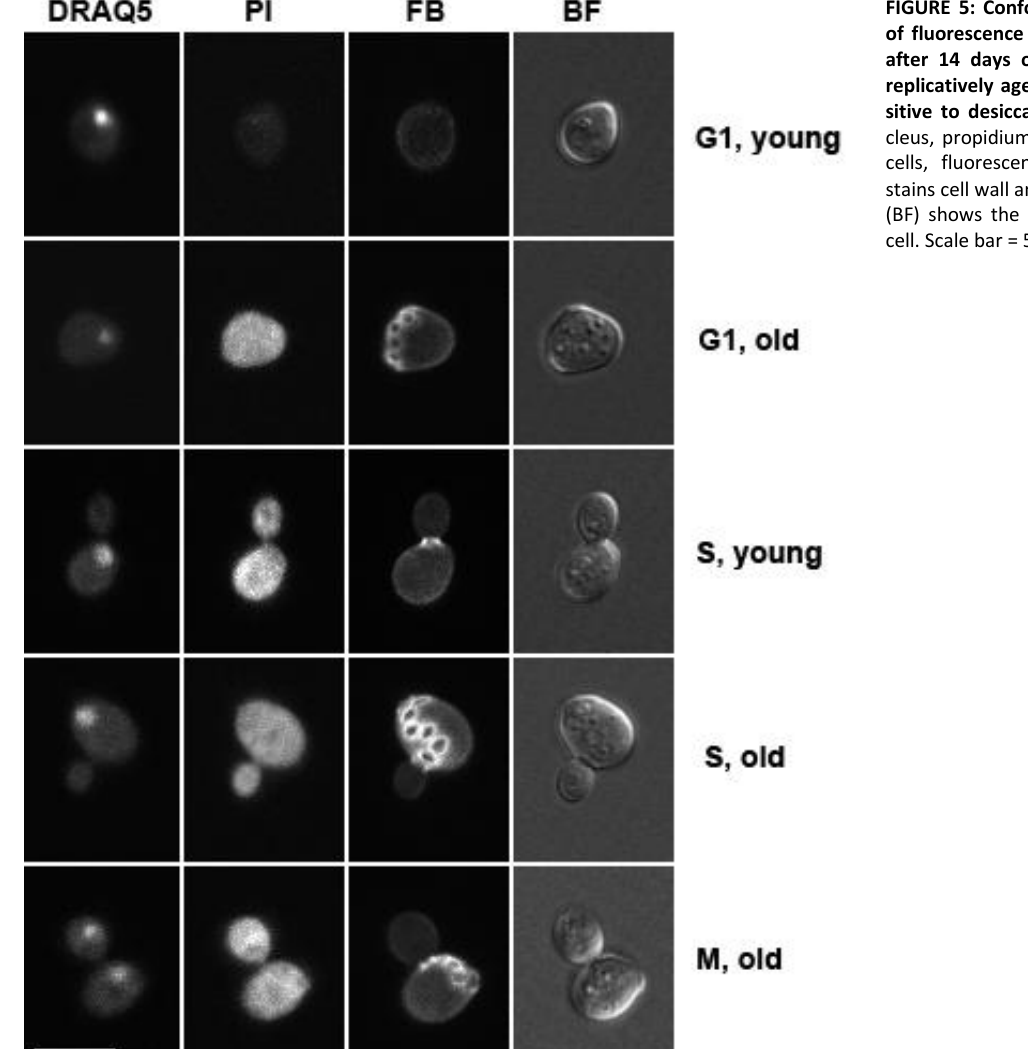
FIGURE 5: Confocal microscopy images of fluorescence stained log-phase cells after 14 days of desiccation, showing replicatively aged cells were more sen- sitive to desiccation. DRAQ5 stains nu- cleus, propidium iodide (PI) stains dead cells, fluorescence brightener 28 (FB) stains cell wall and bud scars, bright field (BF) shows the overall structure of the cell. Scale bar = 5